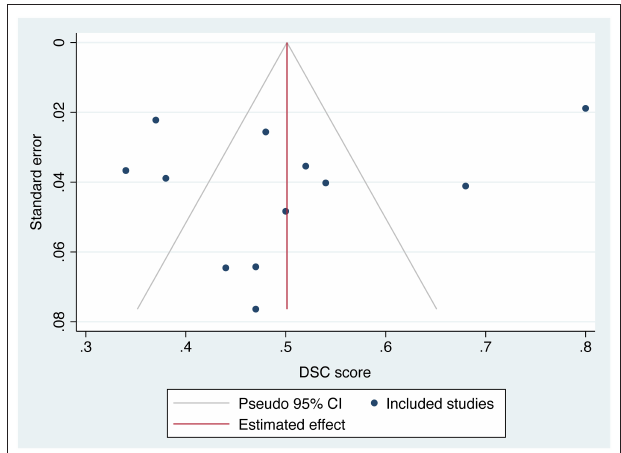
FIGURE 4 | Funnel plot of the included studies. The effect size of mean dice similarity coefficient (DSC) score was displayed on the horizontal axis. Standard error was plotted on the vertical